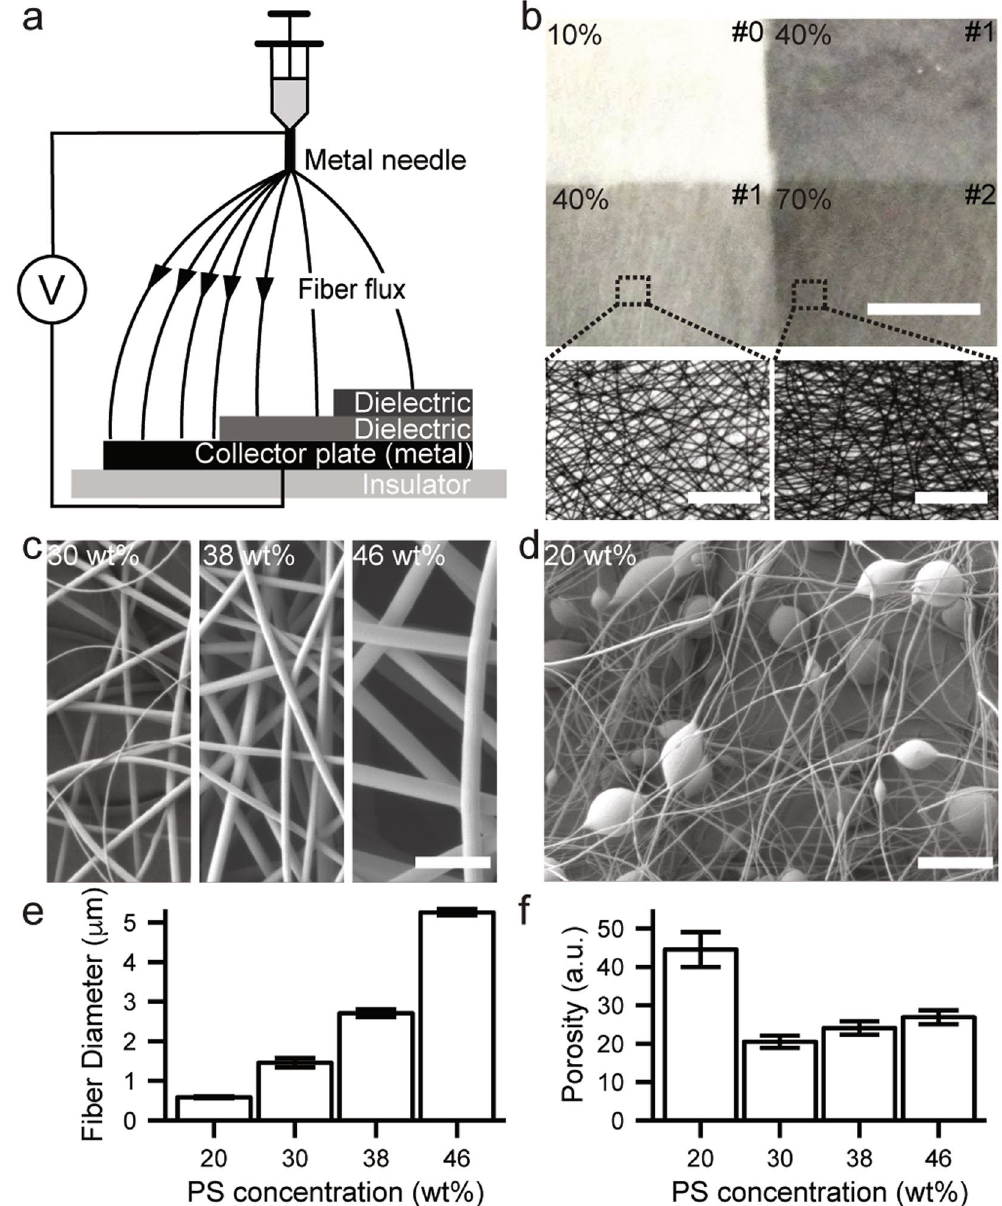
Figure 1. ( a ) A schematic illustration of electrospinning with controlled structural parameters such as fiber density. ( b ) The optical micrograph of density-varied electrospun fibers under low (upper, scale bar: 500 μ m) and high magnifications (lower, scale bar: 100 μ m). The upper-right metrics represent the number of stacked paraffin films. ( c ) and ( d ) Scanning electron microscopy (SEM) images of diameter-controlled electrospun fibers and microbead-incorporated nanofiber mesh (scale bars: 20 μ m). ( e ) and ( f ) Plots of fiber diameter (n = 25, 30, 30 and 30 fibers for 20, 30, 38 and 46 wt% of PS concentration, respectively) and porosity depending on the PS concentration of precursor solution, respectively. All error bars denote standard error of the